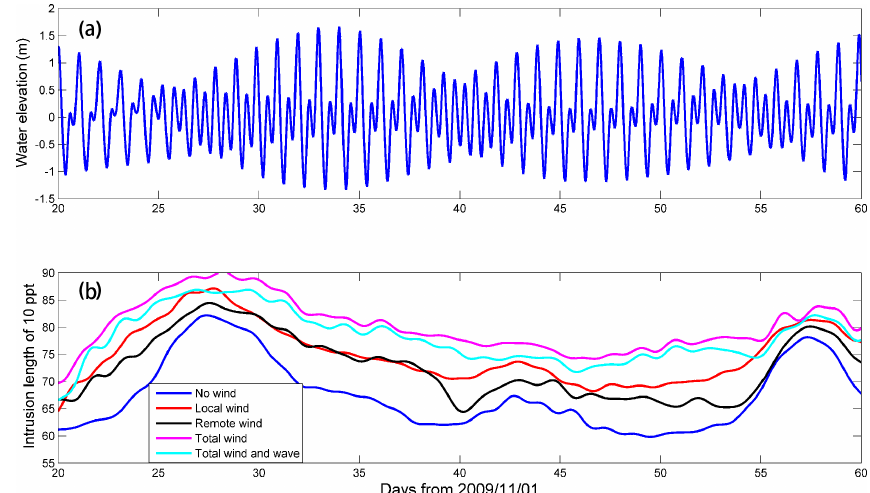
Figure 5. Panel (a) time series of water elevation at the estuary mouth; panel (b) low-pass filtered length of the salt intrusion under different cases.